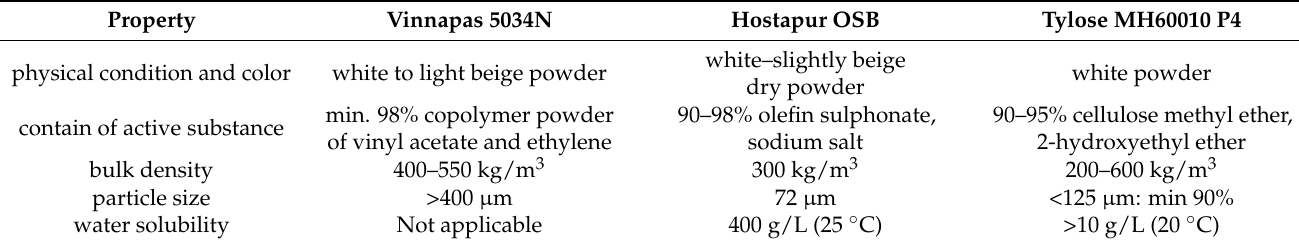
Table 1. Additives used in the study and their physical and chemical